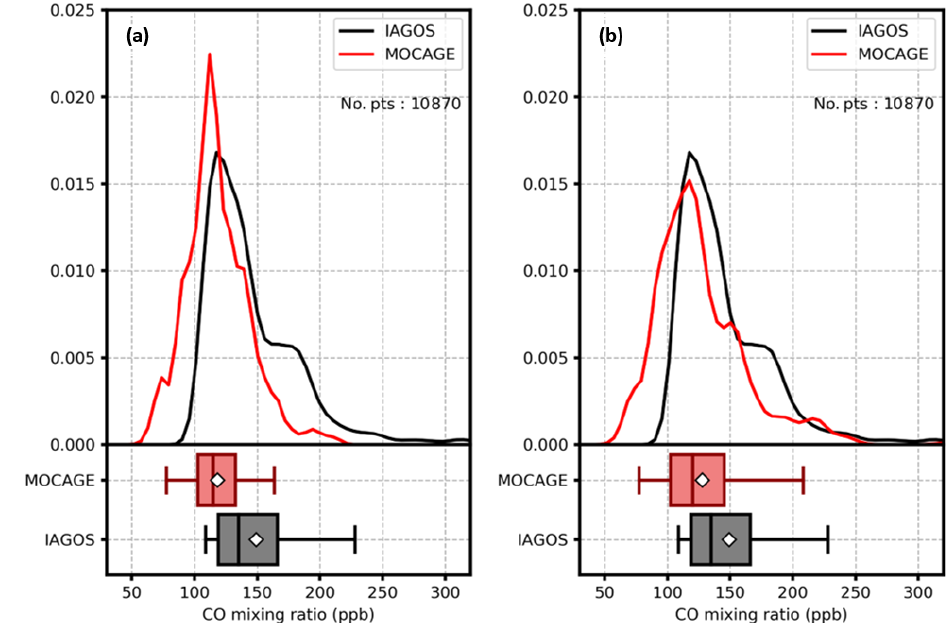
Figure 8. Same as Fig. 6 but for biomass burning plumes originating from boreal